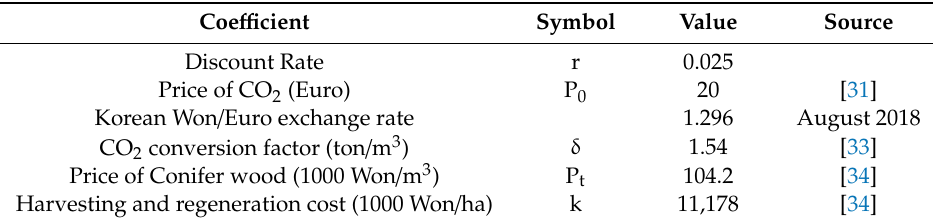
Table 2. Areas and volume of coniferous forest in Korea: by age class.